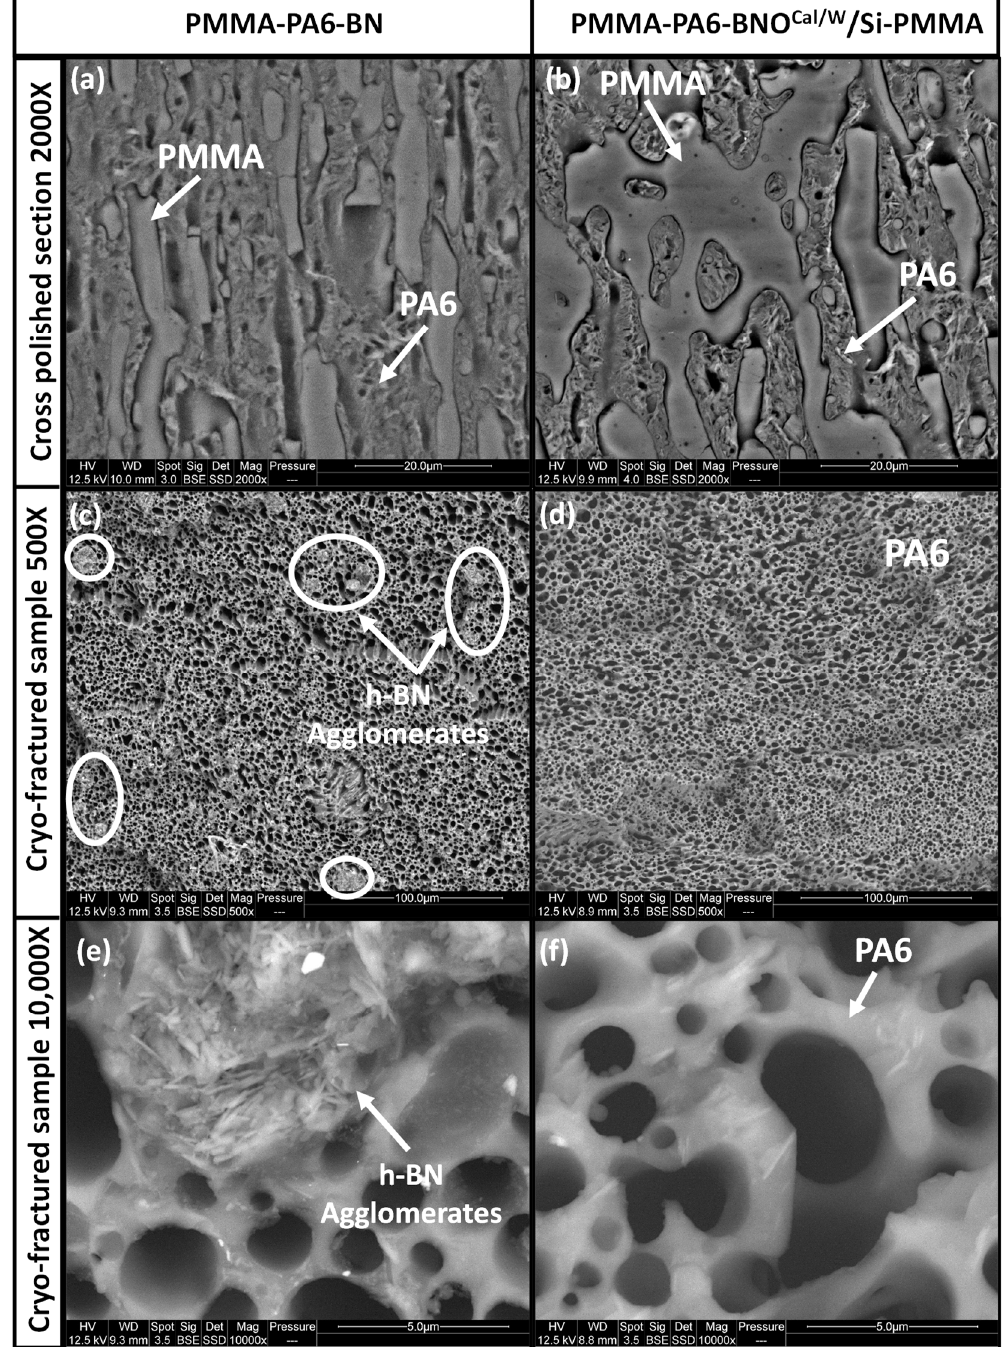
Figure 13. SEM images of PMMA-PA6-h-BN 8 wt% (left column) and PMMA-PA6-BNO Cal/W /Si- PMMA 8 wt% (right column). Parallel cross-polished sections ( a , b ) and perpendicular cryo-fractured surfaces after PMMA solvent extraction ( c – f ).